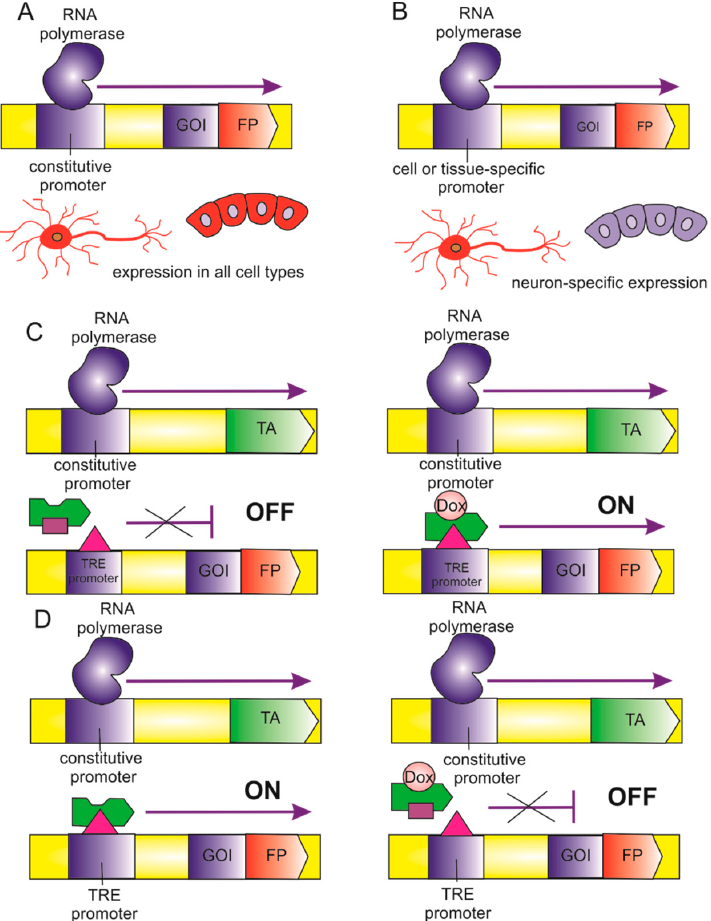
Figure 3. Expression of genetically encoded biosensors. TA—transcriptional activator, TRE—tetracycline responsive element, FP—fluorescent protein, GOI—gene of interest, Dox—doxycycline. ( A ) Constitutive promoter. ( B ) Tissue-specific promoter. ( C ) Doxycycline-inducible expression, the Tet-On system. ( D ) Doxycycline-inducible expression, the Tet-Off